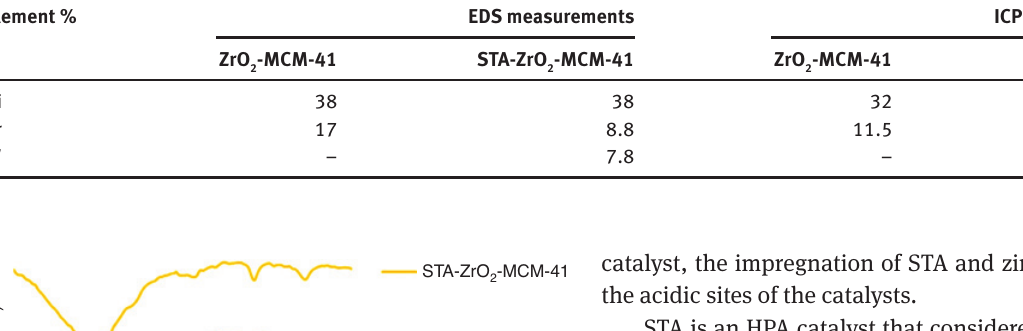
Table 2: The elemental analysis data of MCM-41 supported catalysts. Element %